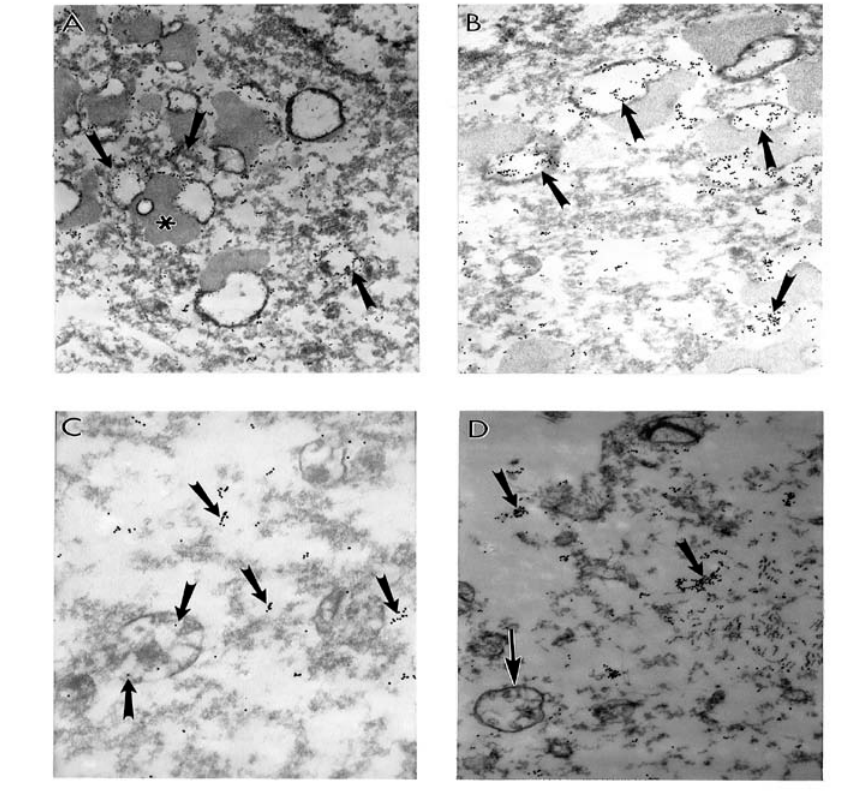
Figure 6. The features of wild, 5kb deleted mitochondria DNA (mtDNA), and COX immunoreactivity in the hippocampus of a postmortem human AD case. A and B. Hippocampal neuron shows wild type mtDNA containing positive signals (17 nm colloidal gold) detection were seen in the completely damaged mitochondria or mitochondria derived lysosomes (single arrows). Areas containing lipofuscin (asterisk) did not show any mtDNA containing positive signals. Magnification X 26,000 and X 20,000, respectively A and B. C. 5kb deleted mtDNA containing gold particles (17 nm) were mostly located in mitochondria–derived lysosomes (single arrows). Original magnification X 33,000. D. Damaged, abnormal mitochondria shows COX positive containing gold particles in the matrix (single arrows, colloidal gold 17 nm). Original magnification X 26,000 (reprinted from [172] with